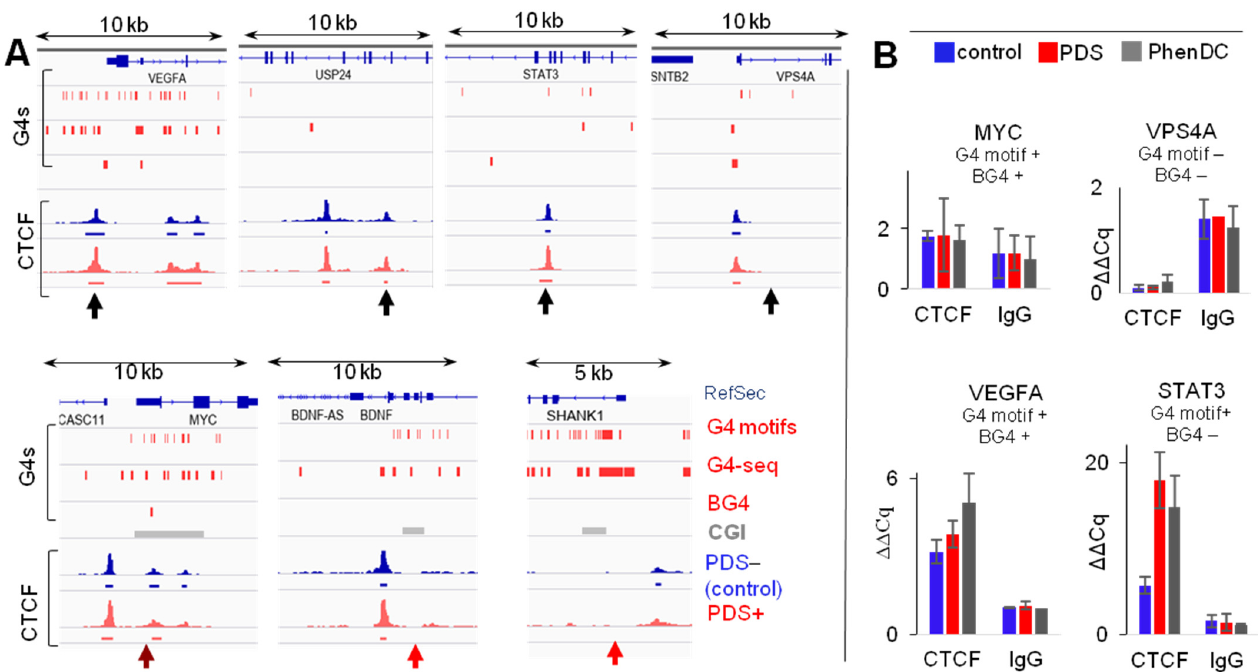
Figure 3. CTCF occupancy at G4 sites in PDS-treated and non-treated cells. ( A ) Genome browser snapshots for VEGFA, USP24, STAT3, VPS4A, MYC, BDNF and SHANK promoter regions/gene bodies harboring G4 motifs, G4-seq peaks, G4 ChIP-seq (BG4) peaks and/or CTCF-bound sites in pyridostatin (PDS)-treated and non-treated K562 cells. Black arrows mark sites analyzed in ChIP-qPCR assays. The CTCF-positive G4-negative site in USP24 was used as a reference, and the CTCF-negative G4-negative site in VPS4A was used as a negative control. Red arrows mark sites predicted to form stable G4s and i-motifs that were used in the binding assays. ( B ) ChIP-qPCR results. The histograms illustrate normalized CTCF occupancy at G4-prone (MYC, VEGFA, and STAT3) and non-G4 (VPS4A) sites relative to the control site (USP24) in non-treated (blue) K562 cells and those treated with PDS (red) or PhenDC3 (grey).